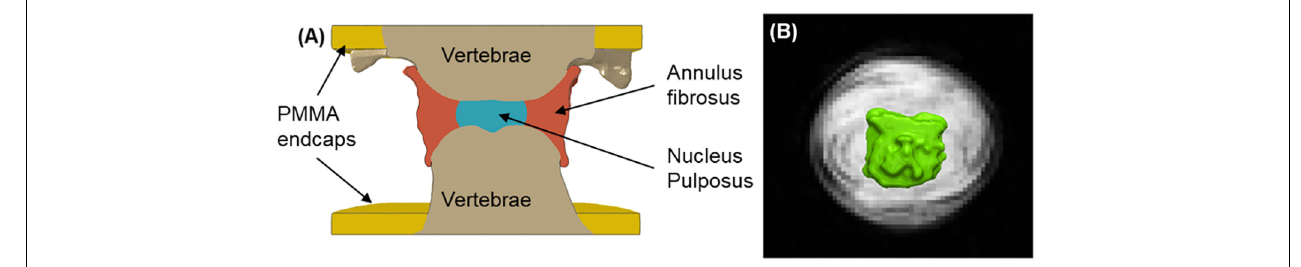
FIGURE 4 | (A) Longitudinal section through an FE model of one specimen (std. cyl. model). (B) Volume rendering (in green) of an MRI-segmented nucleus pulposus, with an axial slice through the centre of the disc, showing defined annulus fibrosus lamellar structure.